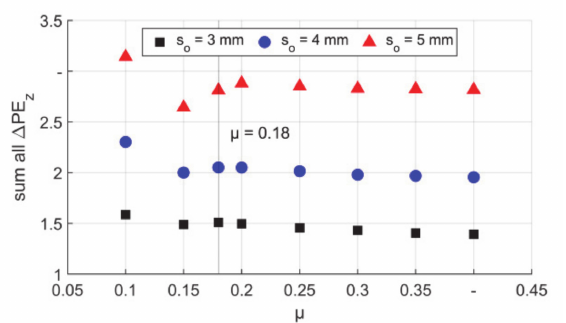
Figure 17. Sum of ∆ PE z between boundaries A and